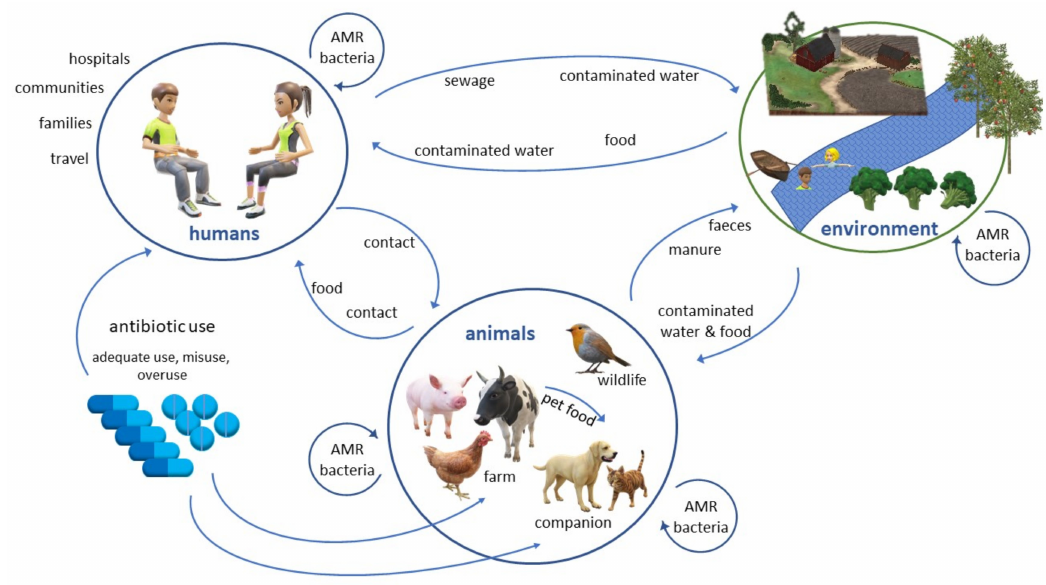
Figure 1. Schematic of potential transmission pathways of AMR bacteria between human, environ- mental and animal